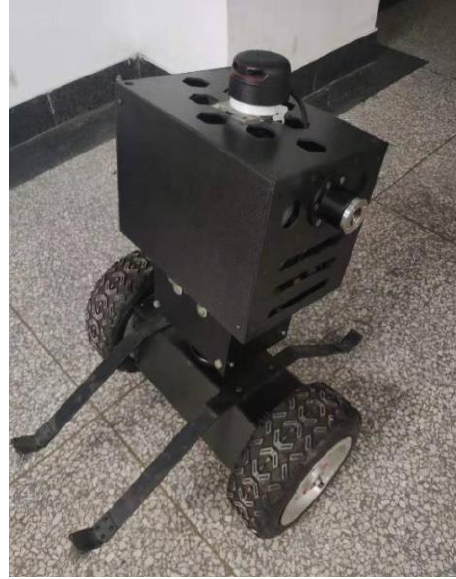
Figure 19. Physical map of inspection robot.